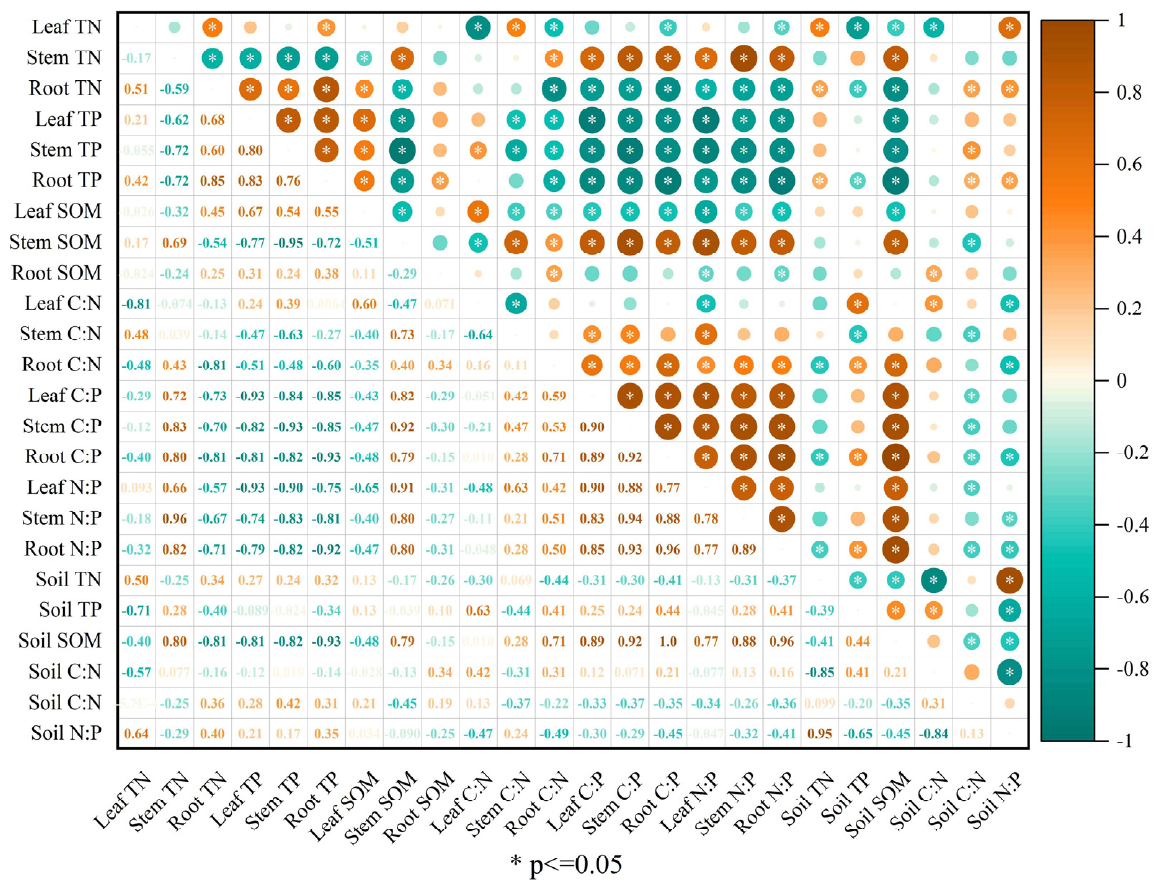
Figure 5. Spearman analysis of nutrition and stoichiometry of C. migao seedlings and soil in the SS